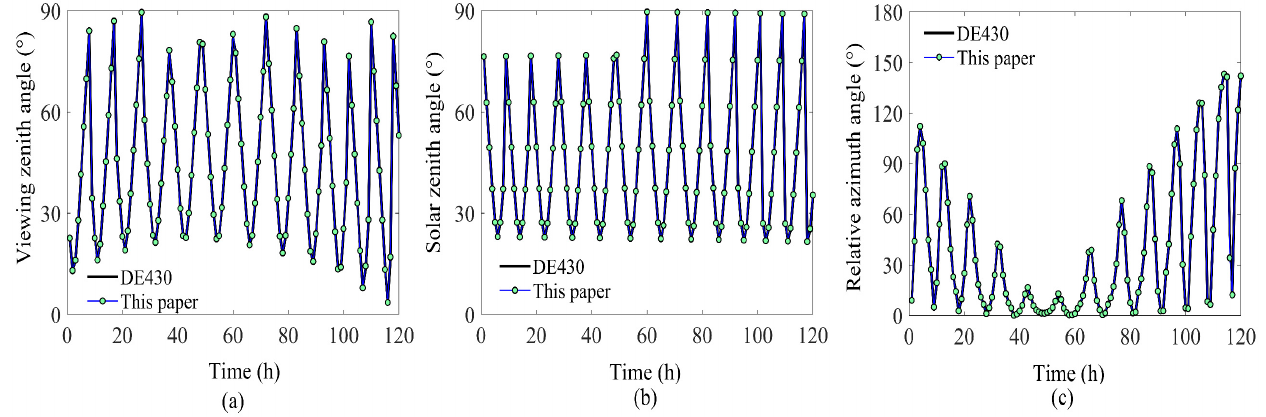
Figure 2. Observational angles, that is, the ( a ) viewing zenith angle, ( b ) solar zenith angle, ( c ) relative azimuth angle, obtained based on the method proposed in this paper and DE430.